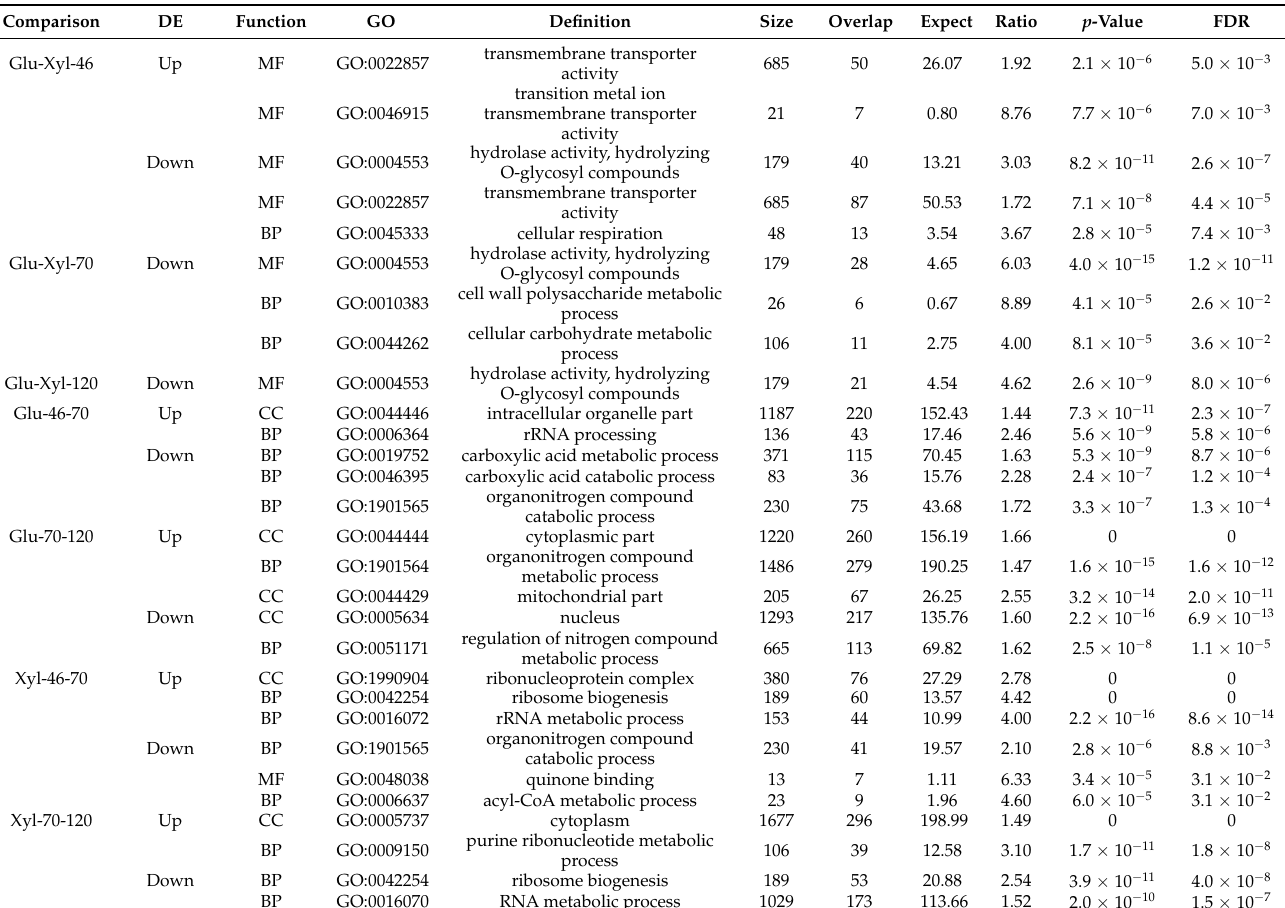
Table 2. Functional enrichment of differentially expressed genes in Saitozyma podzolica DSM 27192 grown on glucose compared to xylose during fed batch cultivation based on WebGestalt. BP, CC and MF represent biological process, cellecular component and molecular function, respectively. DE and FDR represent differential expression and false discovery rate,